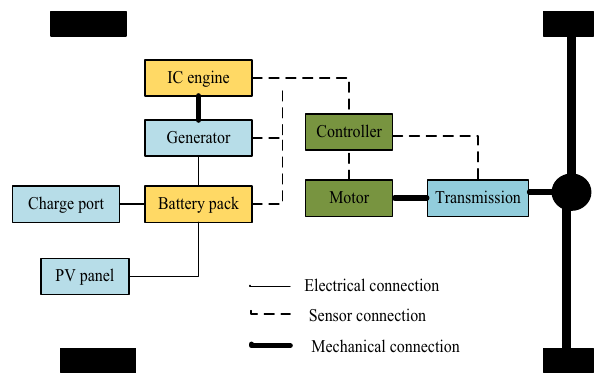
Fig. 3 Block diagram of PVHEV